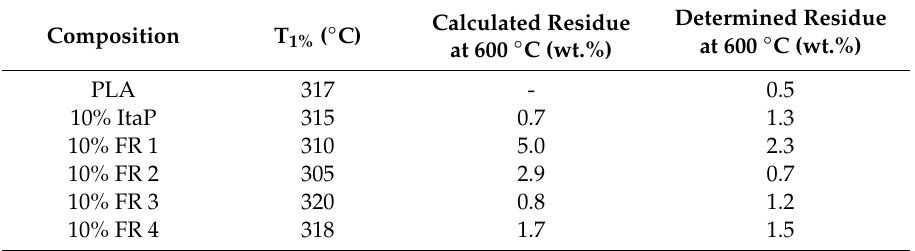
Figure 5. TGA curves of the flame retardant formulations with a heating rate of 10 K / min in nitrogen atmosphere. Table 2. Thermal Properties of the Flame Retardant Formulations.